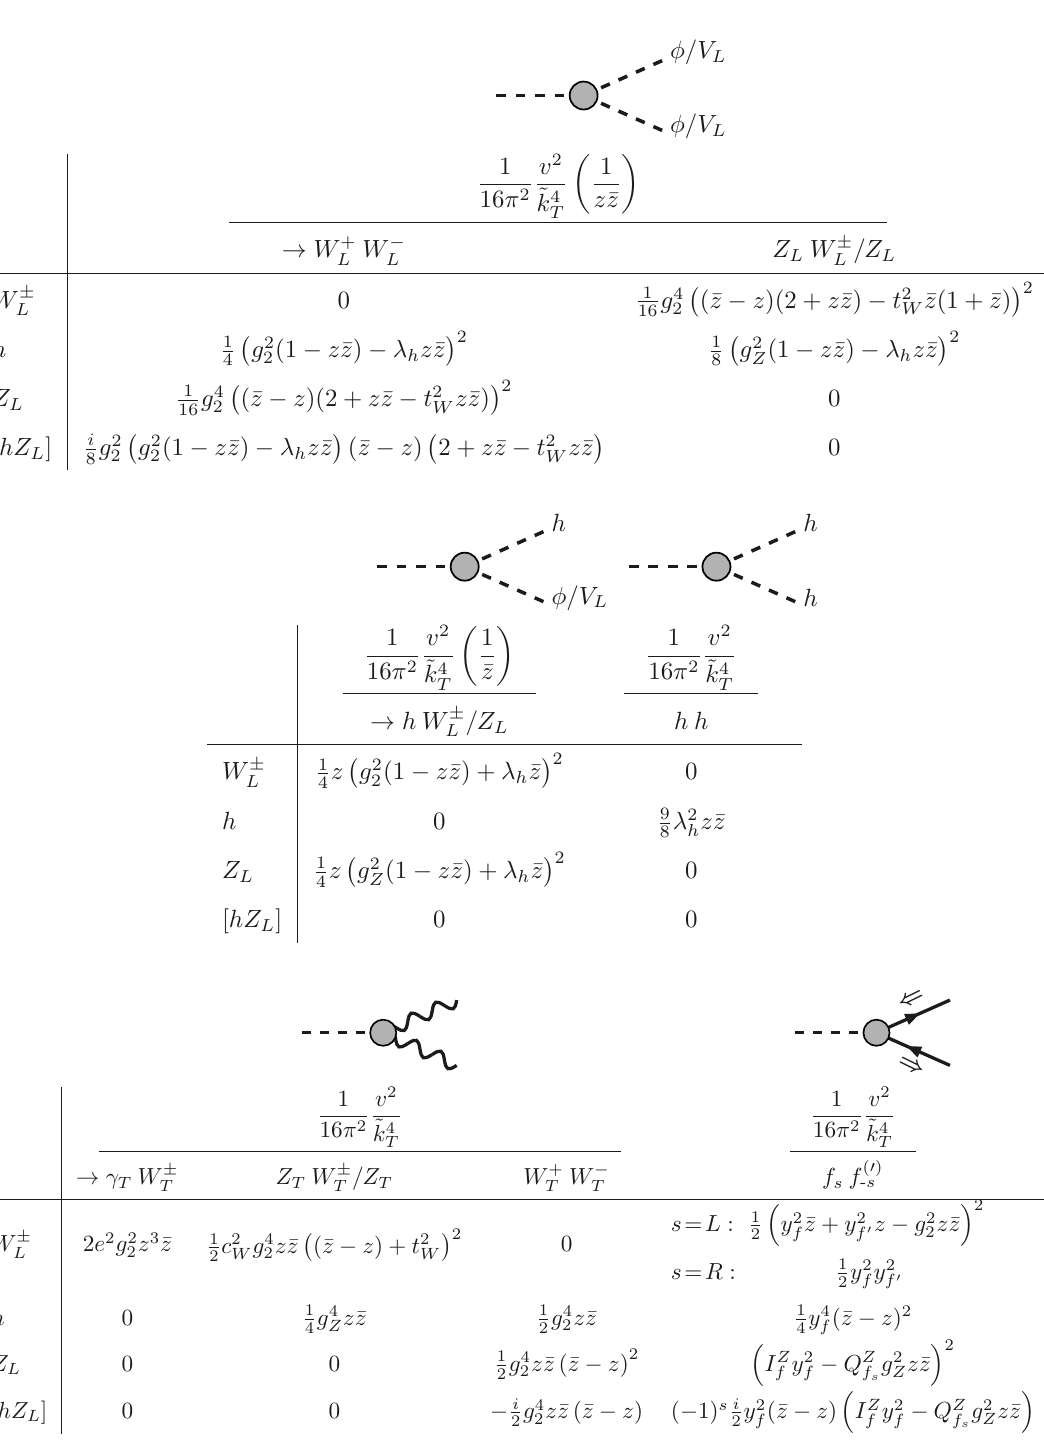
Table 6. Ultra-collinear longitudinal vector boson and Higgs boson splitting functions d The Higgs quartic coupling λ h is normalized such that m 2 [ hZ L ], the ˜ k 4 conventions are as in tables 4, 5 and in appendix